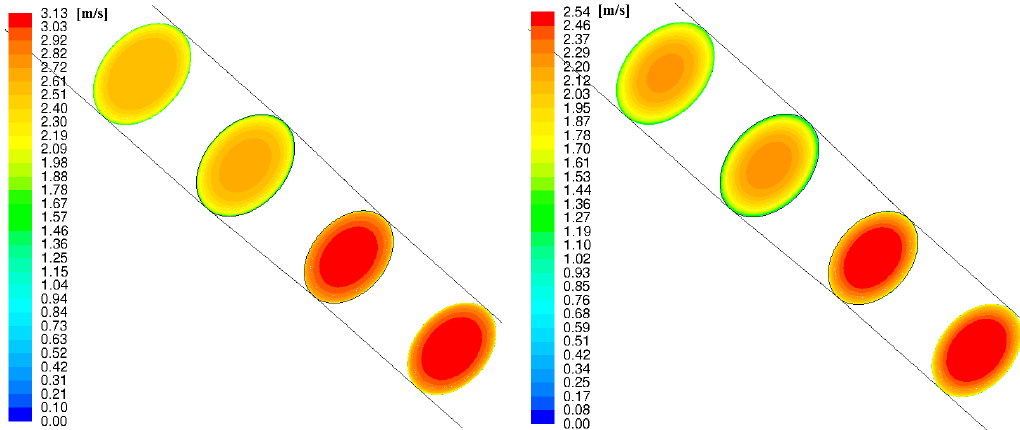
Figure 7. The water velocity contours in the penstock part containing the cone pipe for discharge of Q = 35 m 3 /s in turbine regime ( left view ) and for discharge of Q = 28 m 3 /s in pump regime ( right view ) .